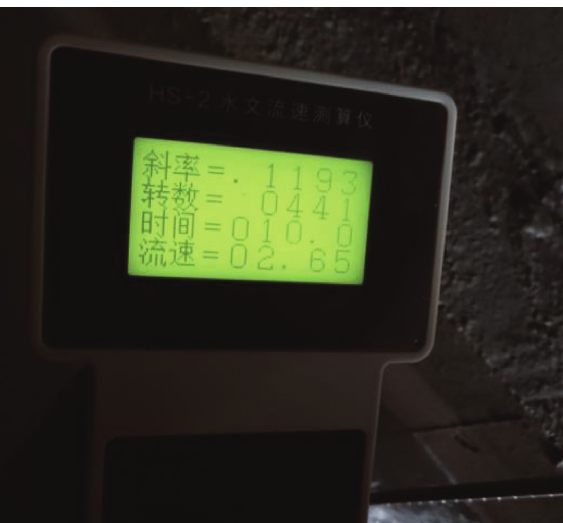
Figure 16: Water inflow